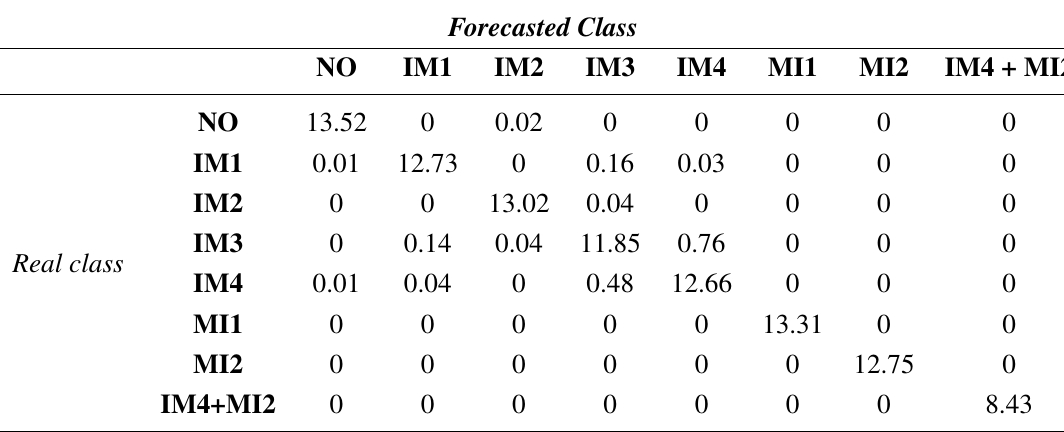
Table 7. Confusion matrix for the linear SVM